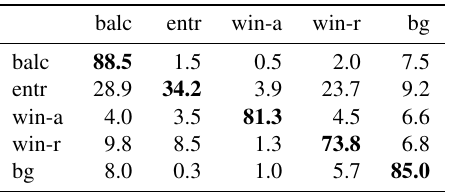
Table 7: Confusion matrix using aggregates of A 2 to A 5 , accu- racy 79 . 8 , see Table